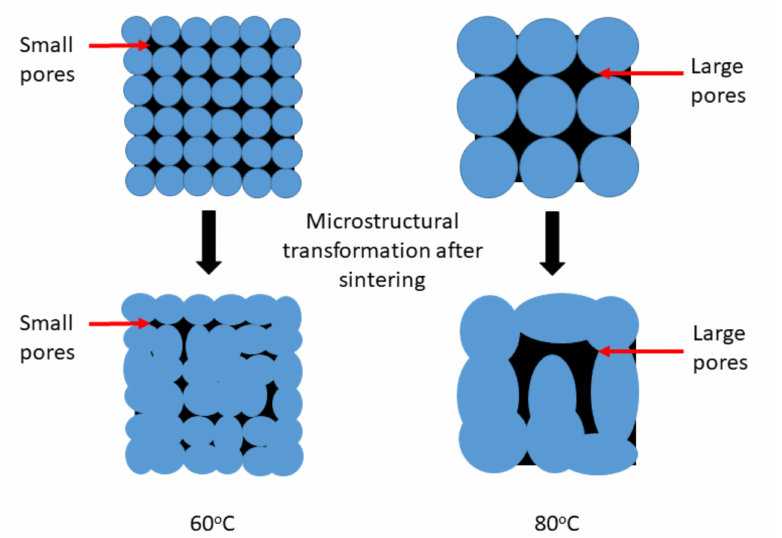
Figure 10. Schematic image of the pores in larger and smaller particle sizes and the transformation after sintering, based on the SEM images of kaolin-GGBS geopolymer at 60 and 80 ◦